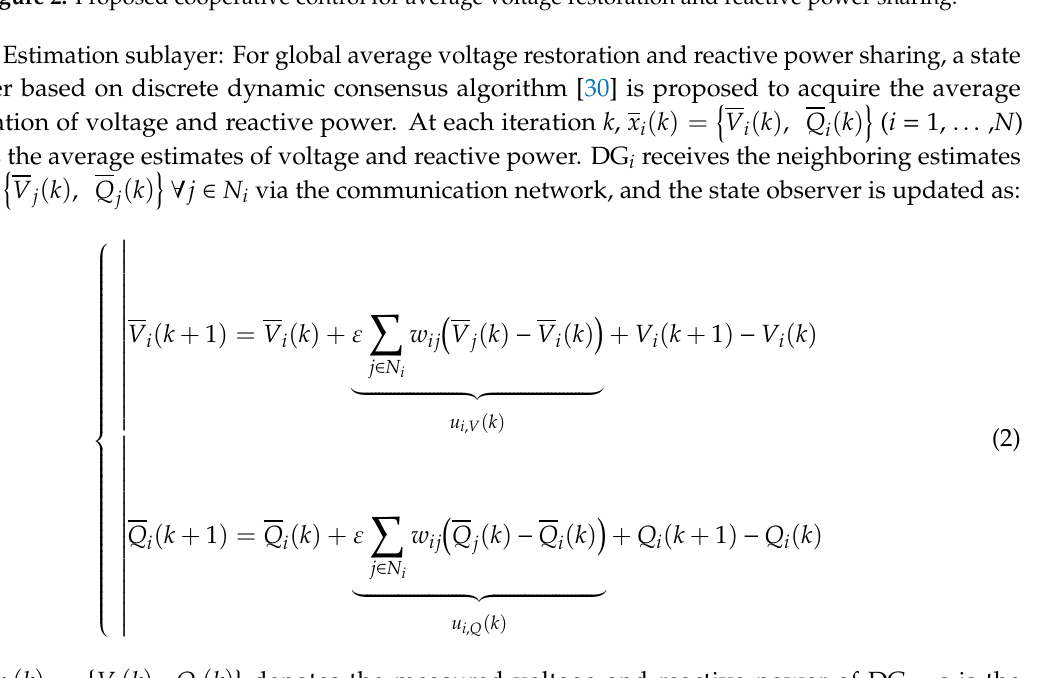
Figure 2. Proposed cooperative control for average voltage restoration and reactive power sharing.